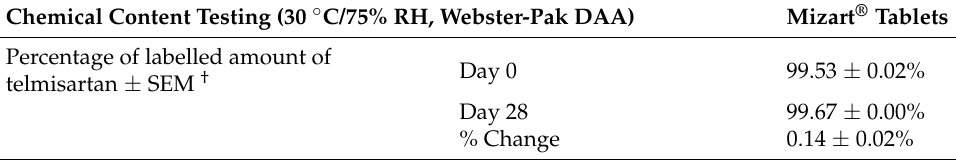
Table 2. Chemical content of Mizart ® tablets as percentage of labelled amount of telmisartan deter- mined by HPLC.